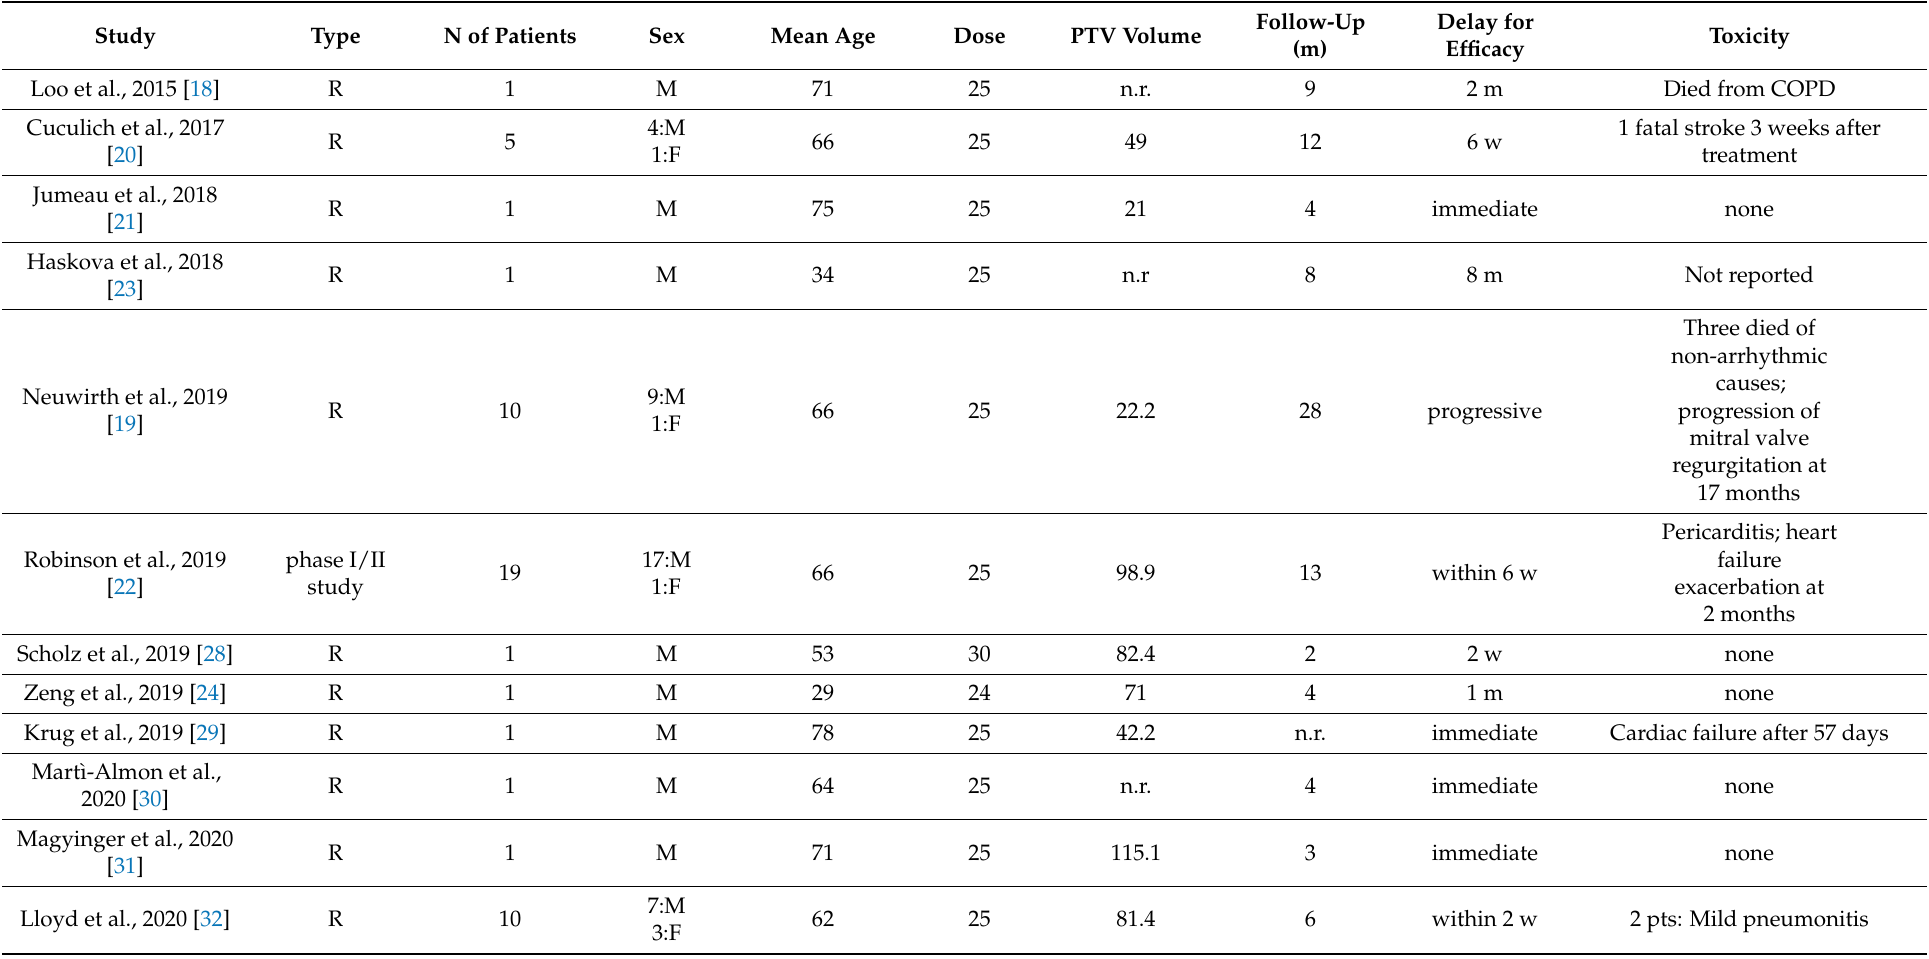
Table 1. Summary table of the literature review of published